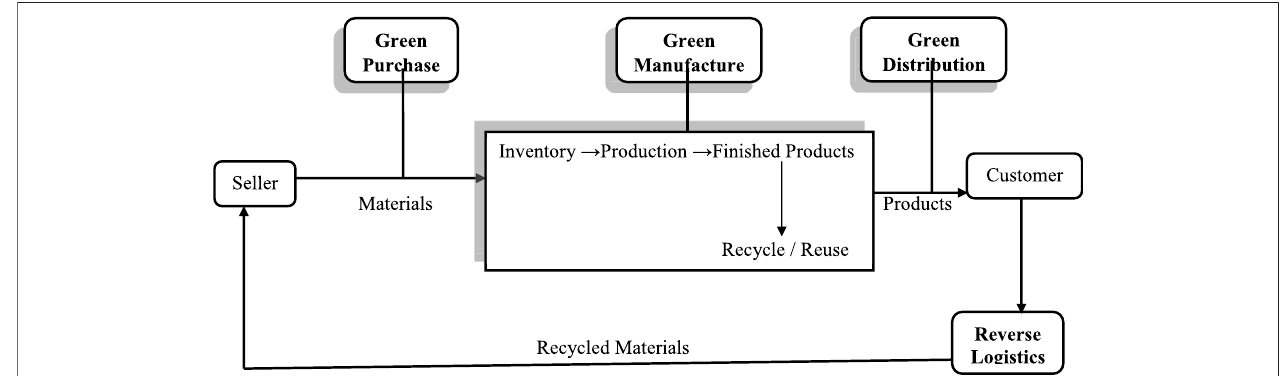
FIGURE 1 | Green supply chain management (GSCM) framework. Source: author ’ s compilation from Khan and Qianli (2017), Tan et al. (2016), and Zhu et al.